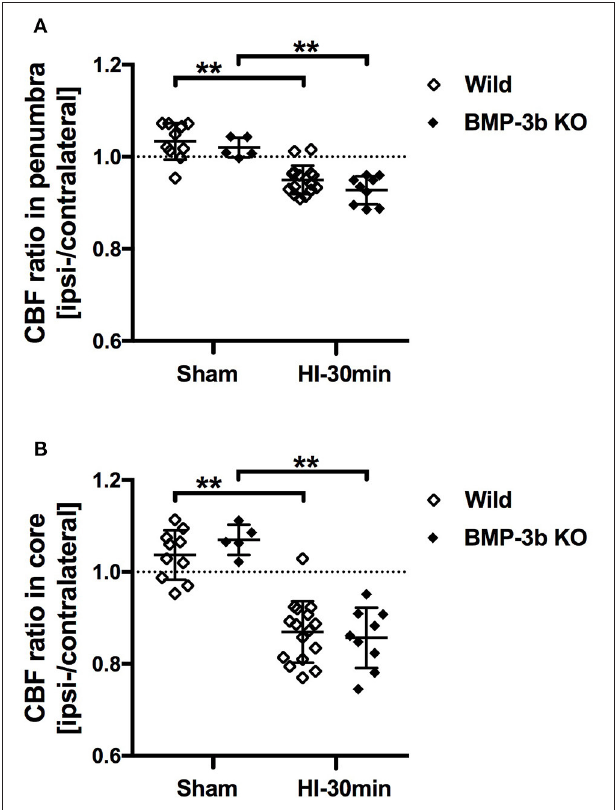
FIGURE 3 | (A) The ratios of CBF in the penumbra region of the ipsilateral (left) hemisphere to the corresponding region of the contralateral (right) hemisphere are shown. (B) The same CBF ratios in the ischemic core regions. Sham, sham-surgery controls; HI-30min, hypoxia-ischemia for 30min. ** p < 0.01.